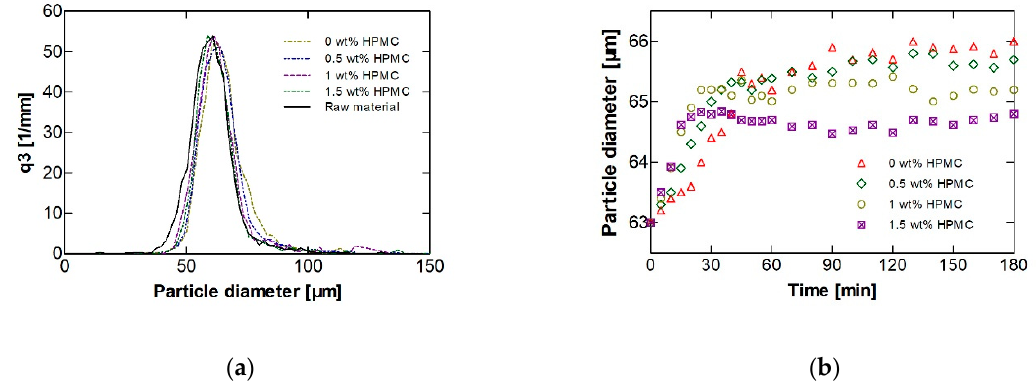
Figure 11. ( a ) Particle size distributions and ( b ) evolution of average particle diameter d 1,3 for different HPMC concentrations.